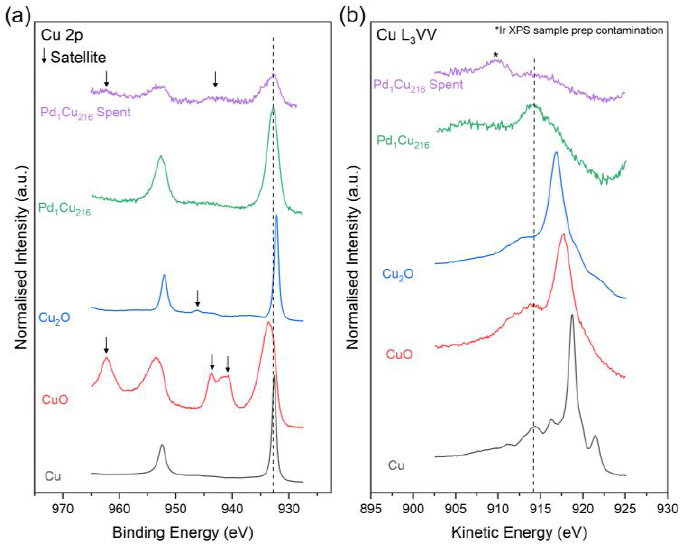
Table 4. XPS data summary. Binding energies for the Cu 2p 3/2 and kinetic energies of the Auger Cu L 3 VV transitions, surface composition and XPS calculated Cu dispersion for the unused and spent catalysts.